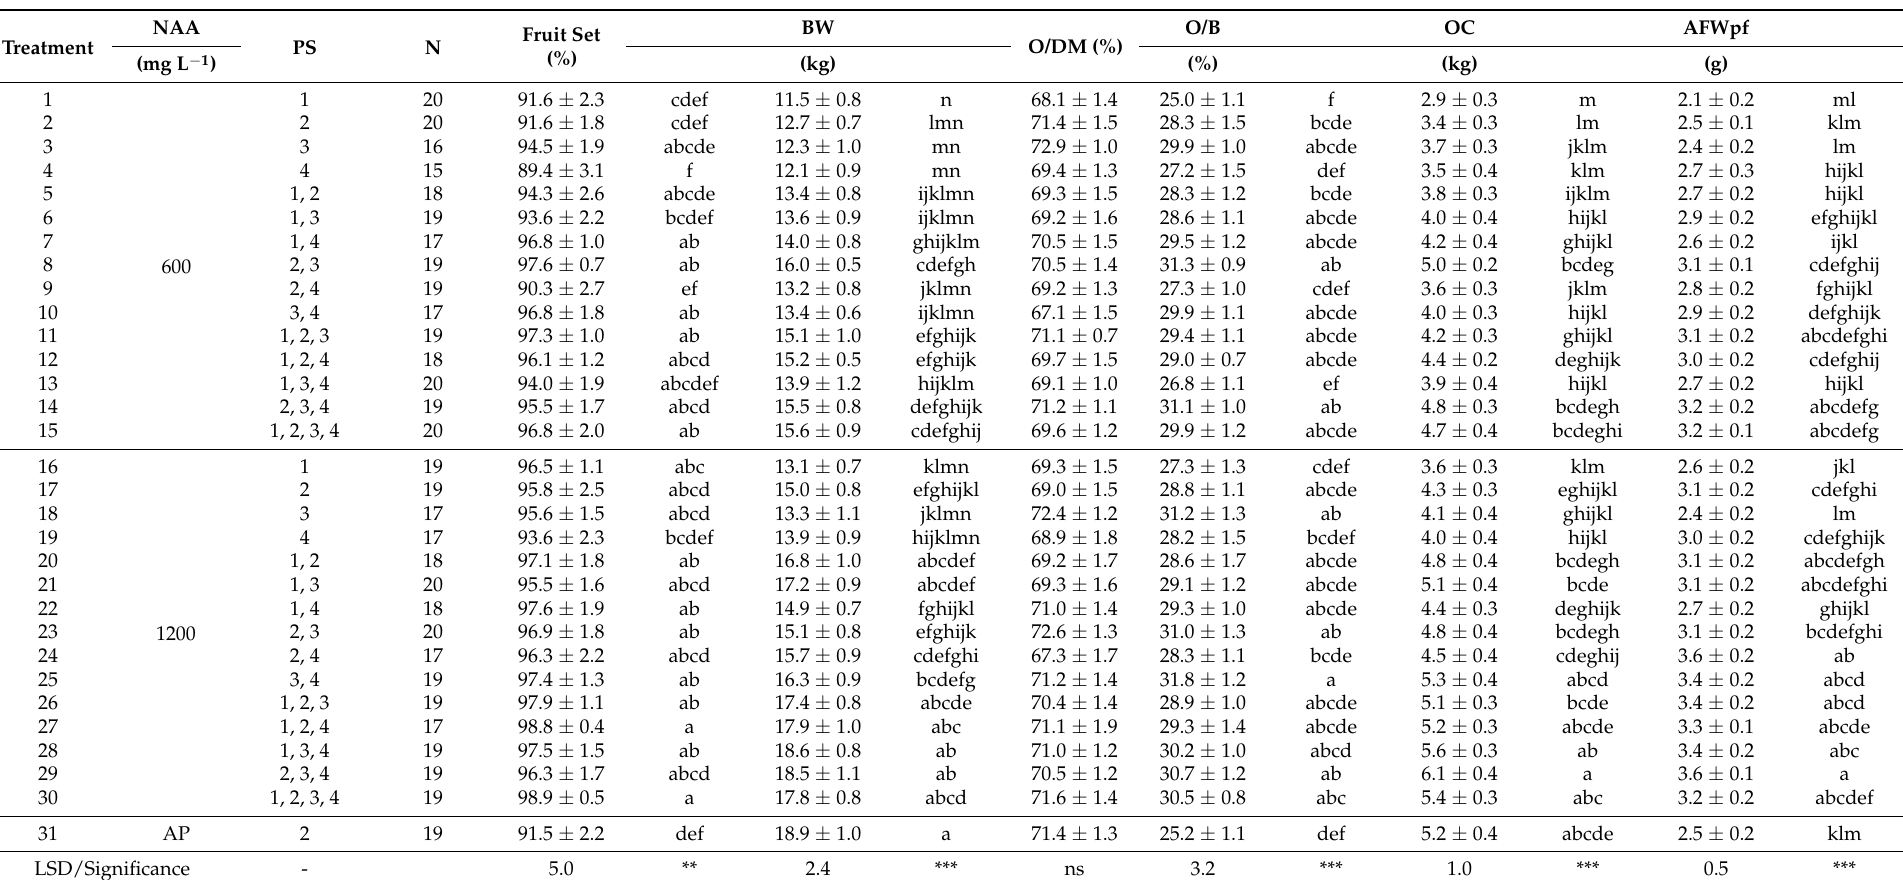
Table 5. Bunch components in OxG hybrids (Coari x La M é ) treated with 600 mg L − 1 or 1200 mg L − 1 NAA for the induction of parthenocarpy. The NAA solutions were applied one, two, three, or four times at different phenological stages (603, 607, 609, 703). Assisted pollination treatment was performed only in inflorescences in anthesis (phenological stage 607).